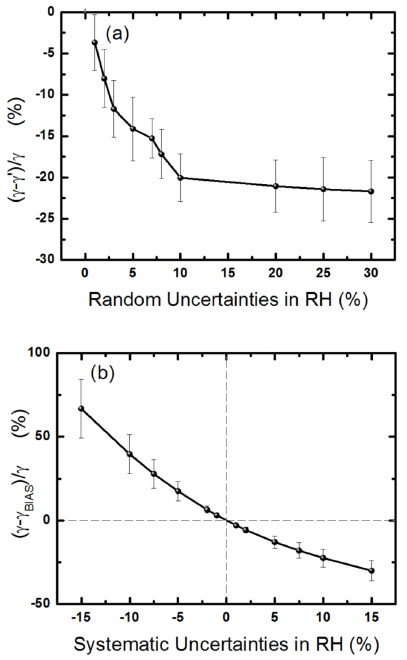
Figure 2. Sensitivity analyses of the hygroscopic growth parameter “ γ ” as function of (a) random errors in the relative humidity and (b) systematic errors in relative